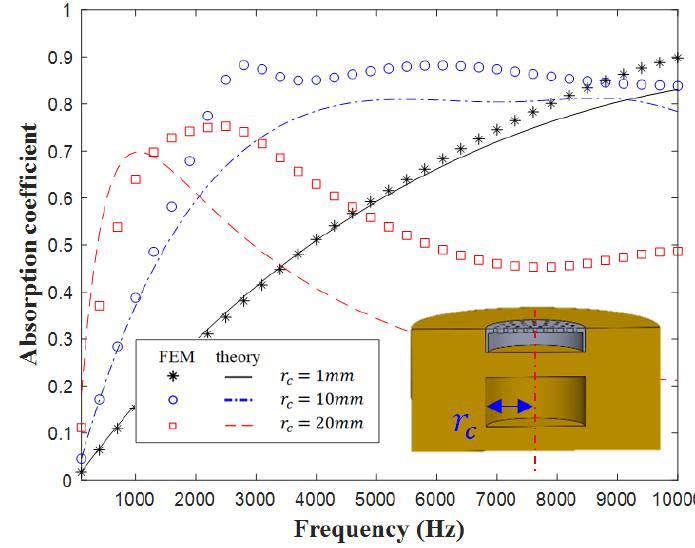
Figure 10. Influence of cavity radius on sound absorption.